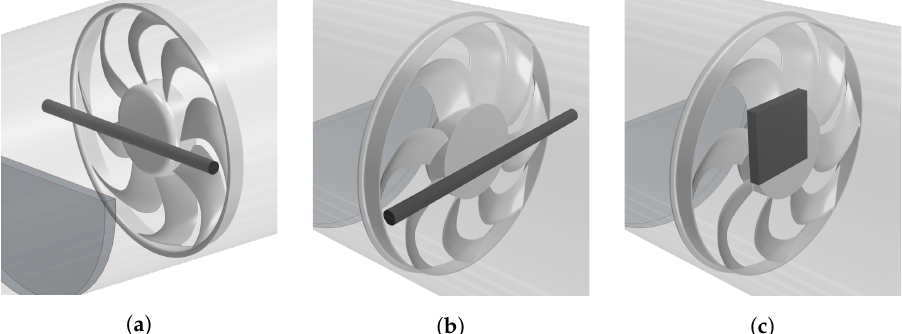
Figure 3. Placement of different obstacles up- and downstream of the MRF interfaces. ( a ) Case F1; ( b ) case F2; ( c ) case F3.